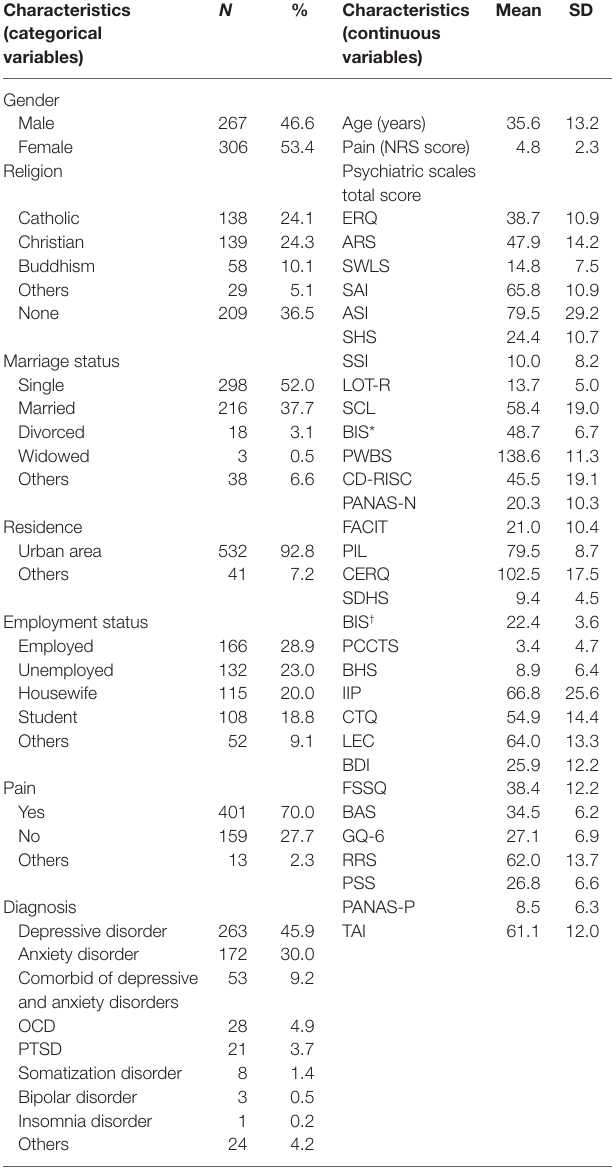
scores of psychiatric scales. characteristics (categorical